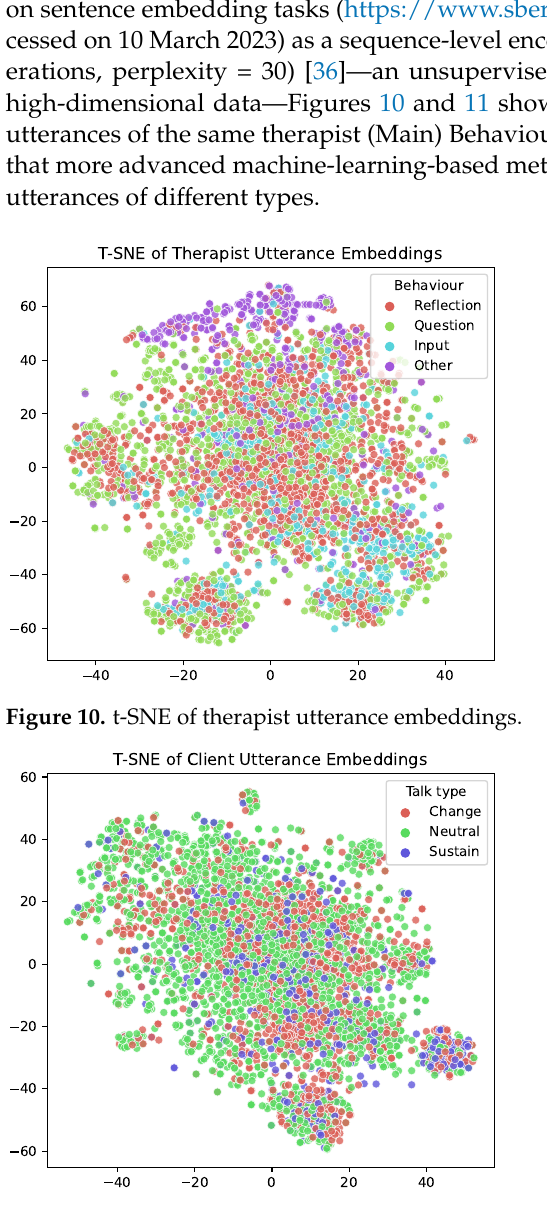
Figure 11. t-SNE of client utterance